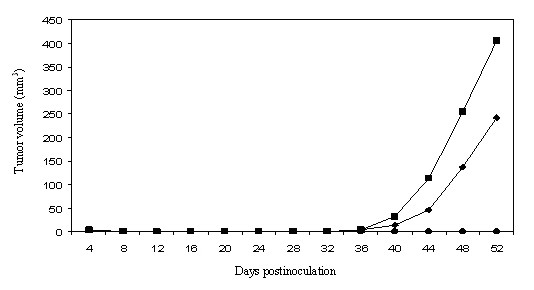
Subcutaneous growth of MPM cells. Subcutaneously growth of MPM cells in nude mice. ◆ = IST-Mes3 (2 × 106 cells injected), ■ = IST-Mes3 (4 × 106 cells injected), ▲ = IST-Mes2 (2 × 106 cells injected), ● = MM-B1 (2 × 106 cells injected). Tumor volume was calculated using the formula: V (mm3) = (D × d2)/2, where d (mm) and D (mm) are the smallest and largest perpendicular tumor diameters, respectively.